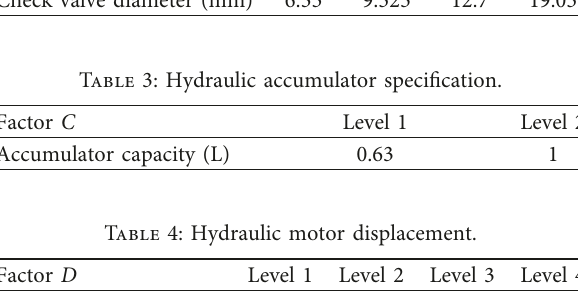
Table 5: Battery/Resistor resistance.